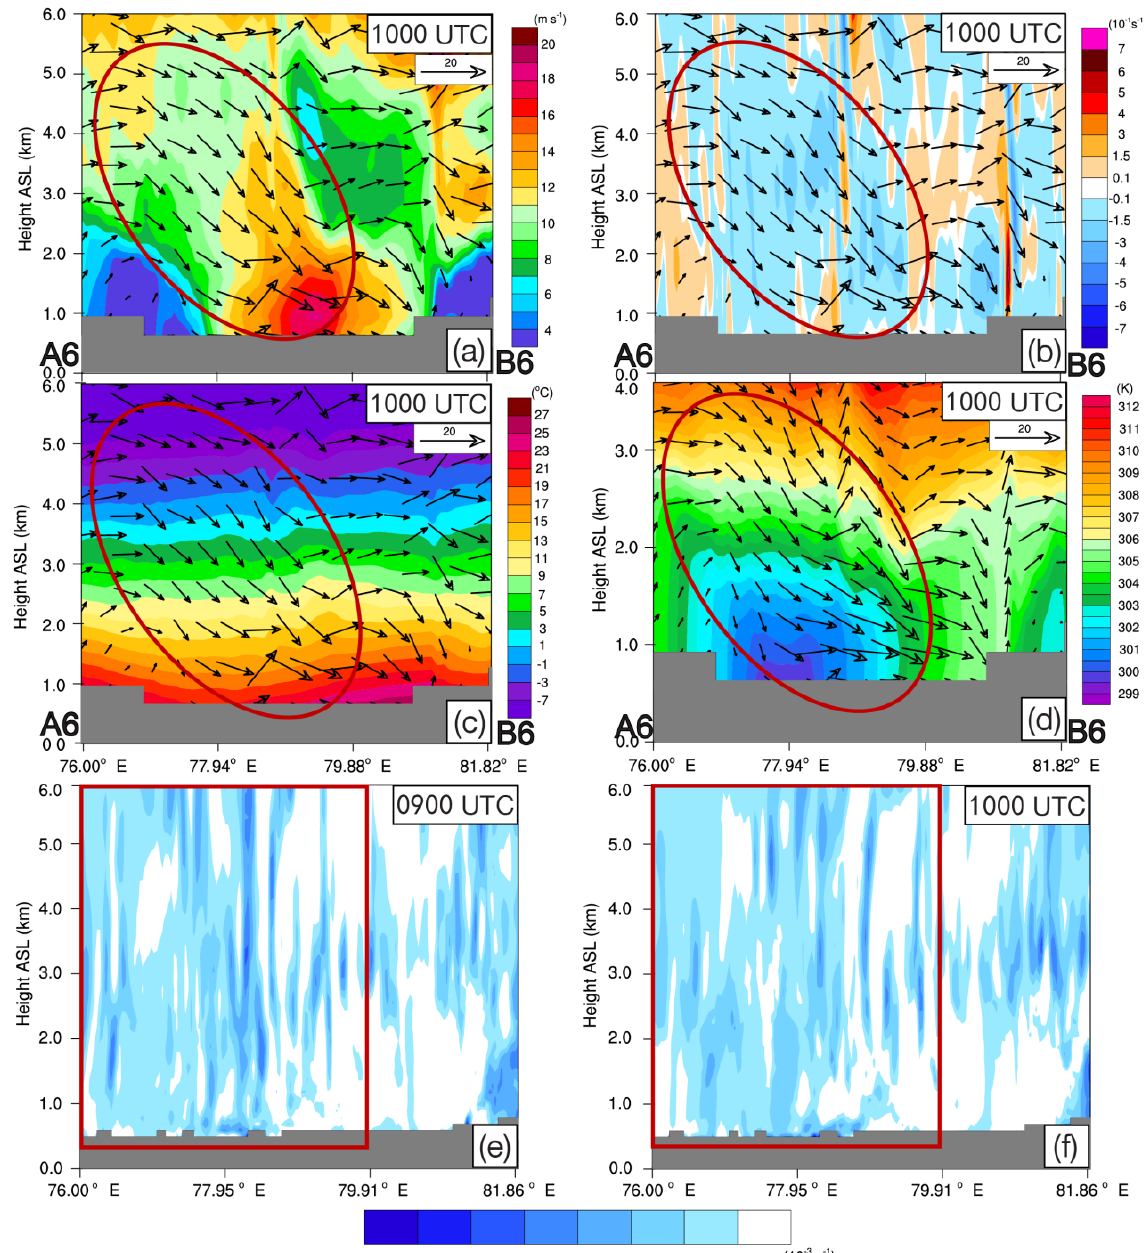
Figure 13. ( a ) Vertical cross section of 3-D composed wind speed (shading and vector arrows, units: m s −1 ) and 3-D composed wind vectors (the vertical wind is magnified ten-fold, units: m s −1 ) along the line A6B6 on 17 June 2016. ( b ) the same as ( a ) but for the vertical velocity (shading, units: m s −1 ). ( c ) and ( d ) are the same as ( a ) but for the temperature (shading, units: °C) and potential tempera- ture (shading, units: K), respectively. ( e , f ) Vertical cross section of the meridional-mean value of vertical vorticity (shading, units: 10 −3 s −1 ) calculated in the blue rectangle area shown in Figure 12a. The specific time is shown in the upper right corner of each panel. The dark grey shading shows the area below ground surface.